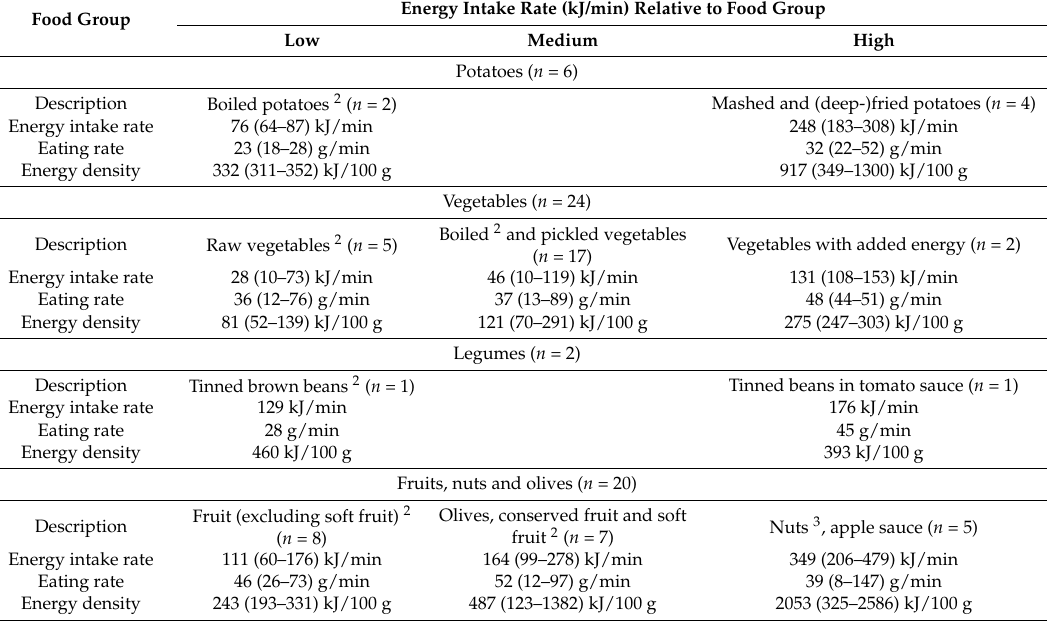
Table 3. Energy intake rate (kJ/min) of foods relative to the other foods within the food group 1